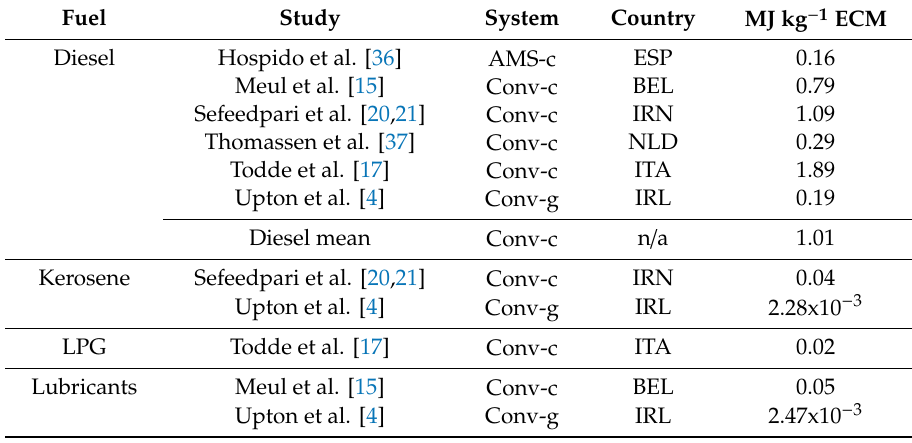
Table 5. Liquid energy consumption breakdown statistics of studies found in literature. Fuel Study